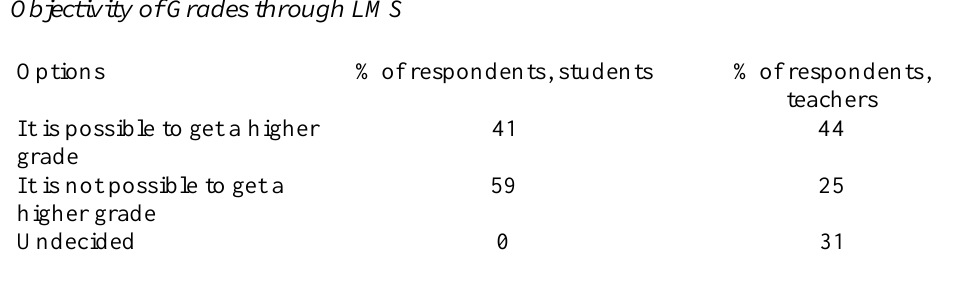
Objectivity of Grades through